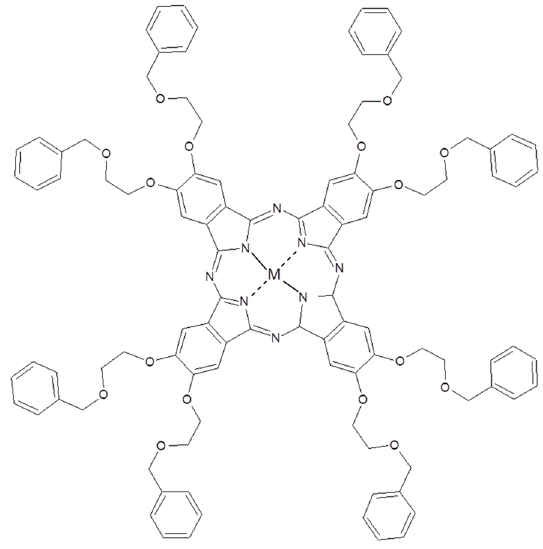
Figure 8. Chemical structure of (2,3,9,10,16,17,23,24-octakis(octyloxy))-29 H ,31 H -phthalocyanine used in